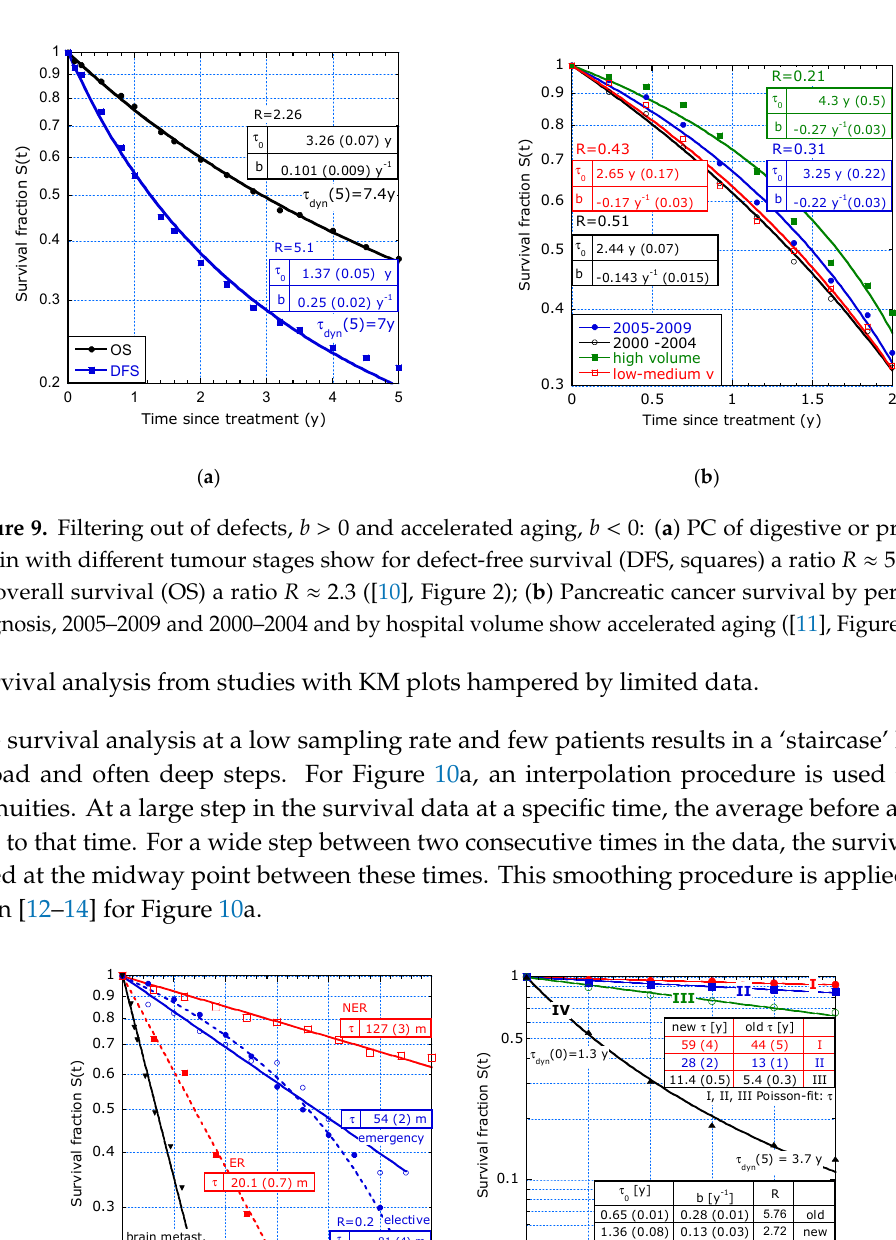
( b ) Figure 11. The survival curves (solid squares) from [16] with a clear transition time t* and curve fits (open squares) in distinct time intervals, starting with accelerated aging and switching abruptly to a lower constant hazard. The log-lin presentation reveals t* and the fit parameters before and beyond t * : ( a ) Figure 11a is from the complete group (111 patients) [16], Figure 1; ( b ) Figure 11b is from 33 patients stratified by prognostic group (intermediate) [16]. The right scale shows the discontinuity in the hazard. 3.2. Merits of Providing Dynamic Lifetime